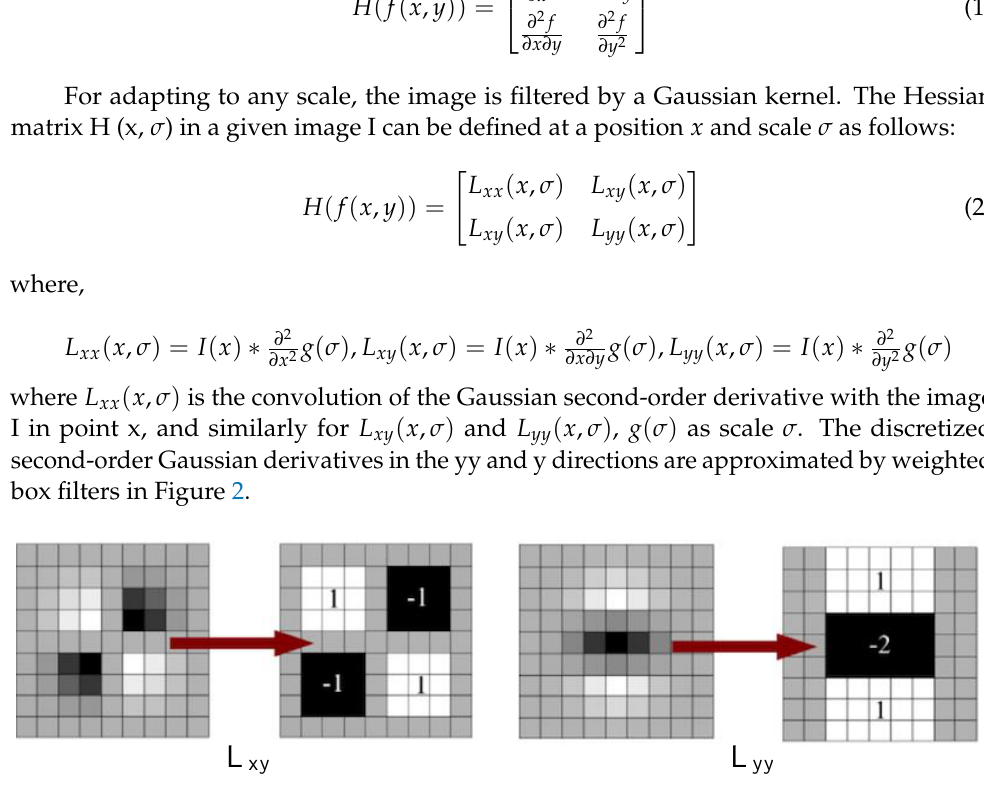
Figure 2. Box filter approximation of second − order Gaussian partial